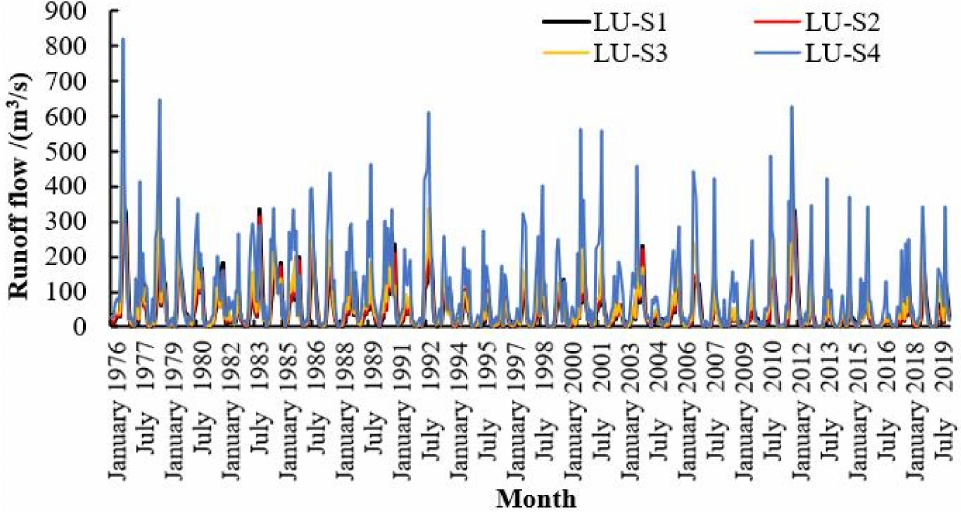
Figure 12. Comparison of simulated monthly runoff trends under different land use